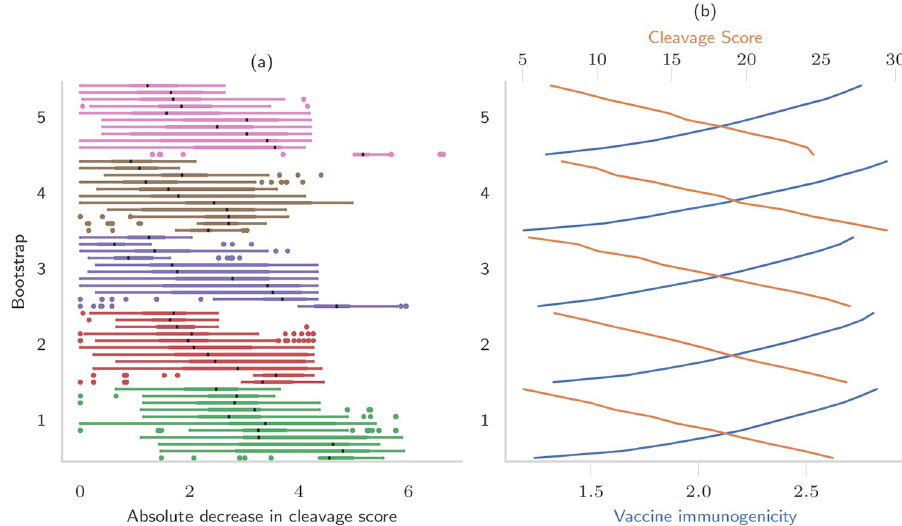
Fig 4. Decrease in cleavage score by randomly permuting string-of-beads vaccines. (a) For each vaccine in the Pareto frontier of each bootstrap, we created 50 new string-of-beads by randomly permuting its epitopes and compared the cleavage scores of the two vaccines. The black dots in the box plots show the median decrease. (b) cleavage score and immunogenicity of the original vaccine with optimized